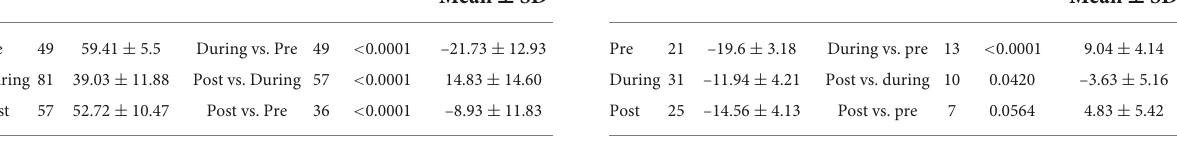
TABLE 3 Ejection fraction prior to TTS, during episode and following recovery.